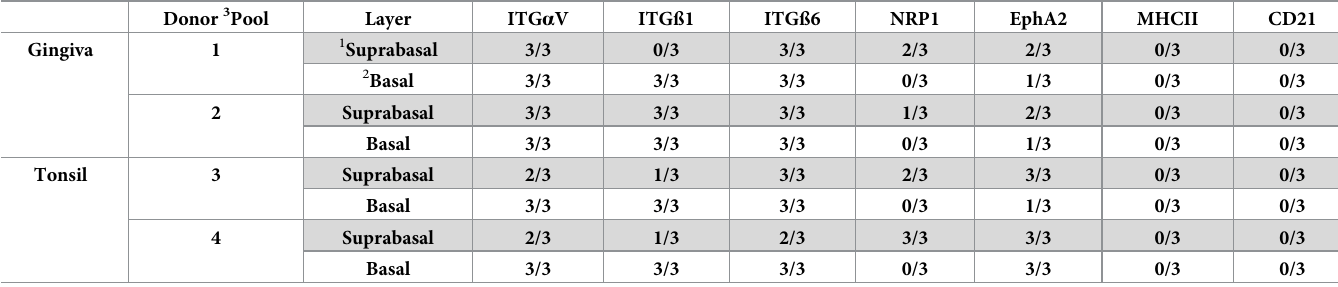
Table 1. EBV receptor localization in organotypic